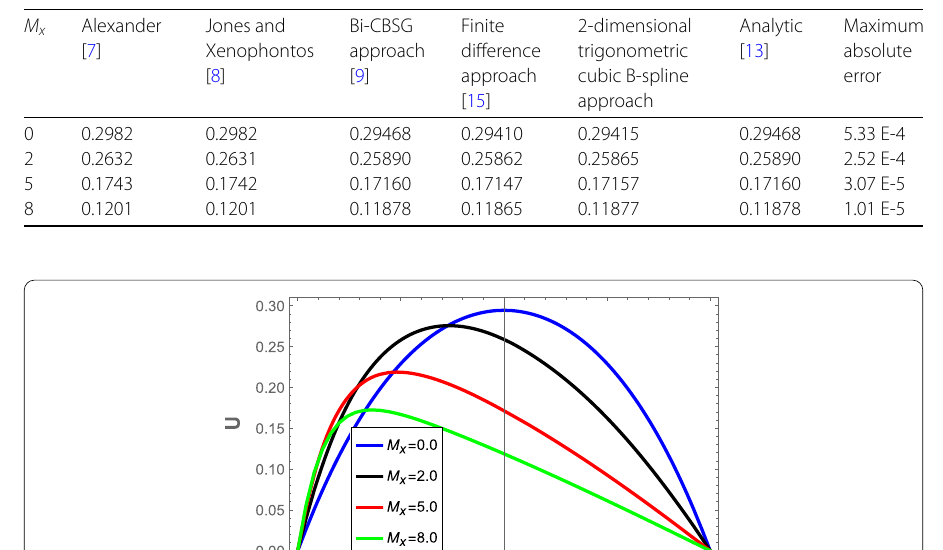
Table 2 U at the middle of the duct